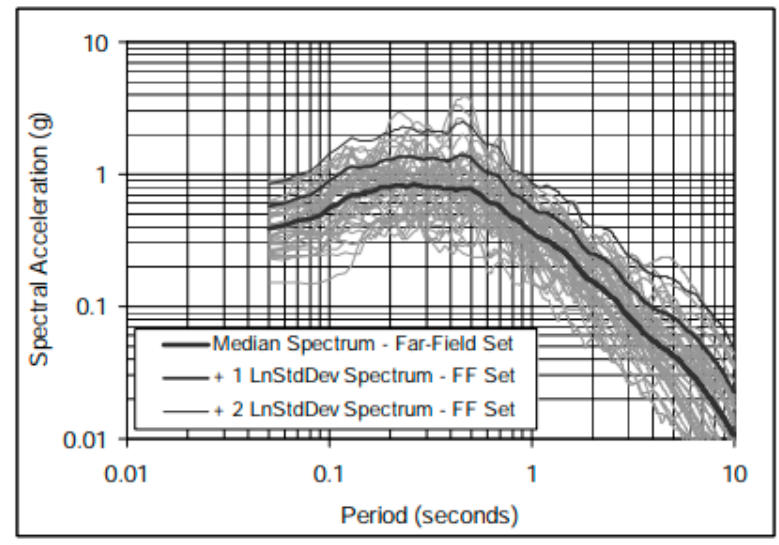
Figure 3. Spectrum of all accelerograms used for incremental dynamic study [20].